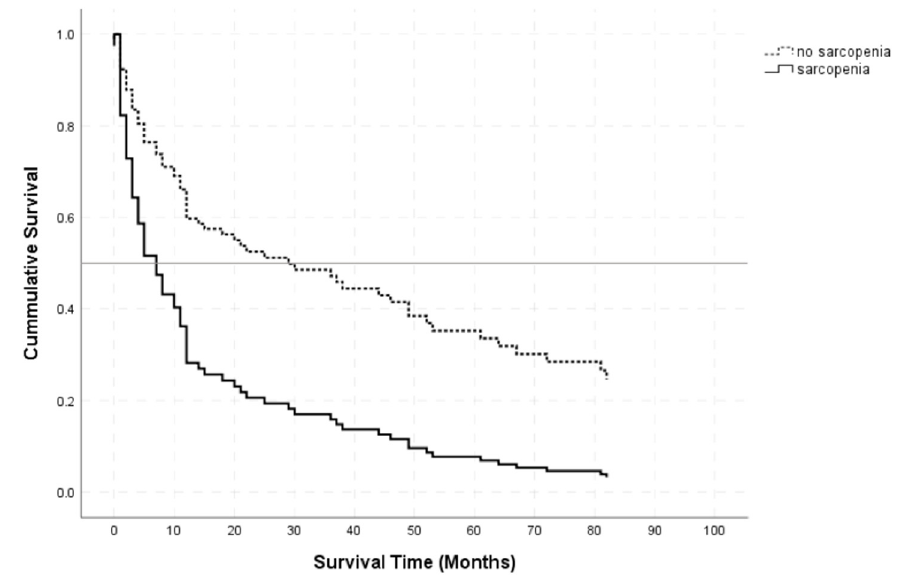
Figure 2. Kaplan–Meier survival curves for patients with TMT values below (black line) and above (dashed line) the sex-related cutoff values.